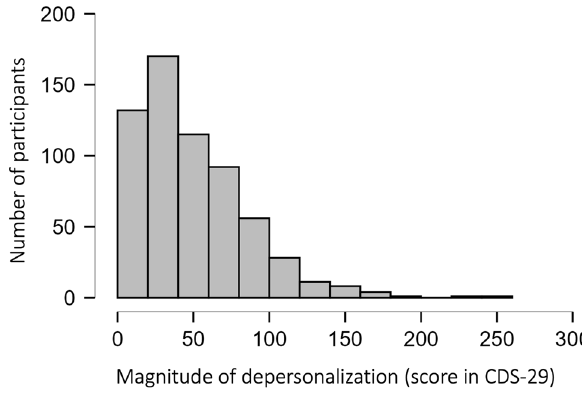
Figure 2. Distribution of total scores in CDS-29 in our